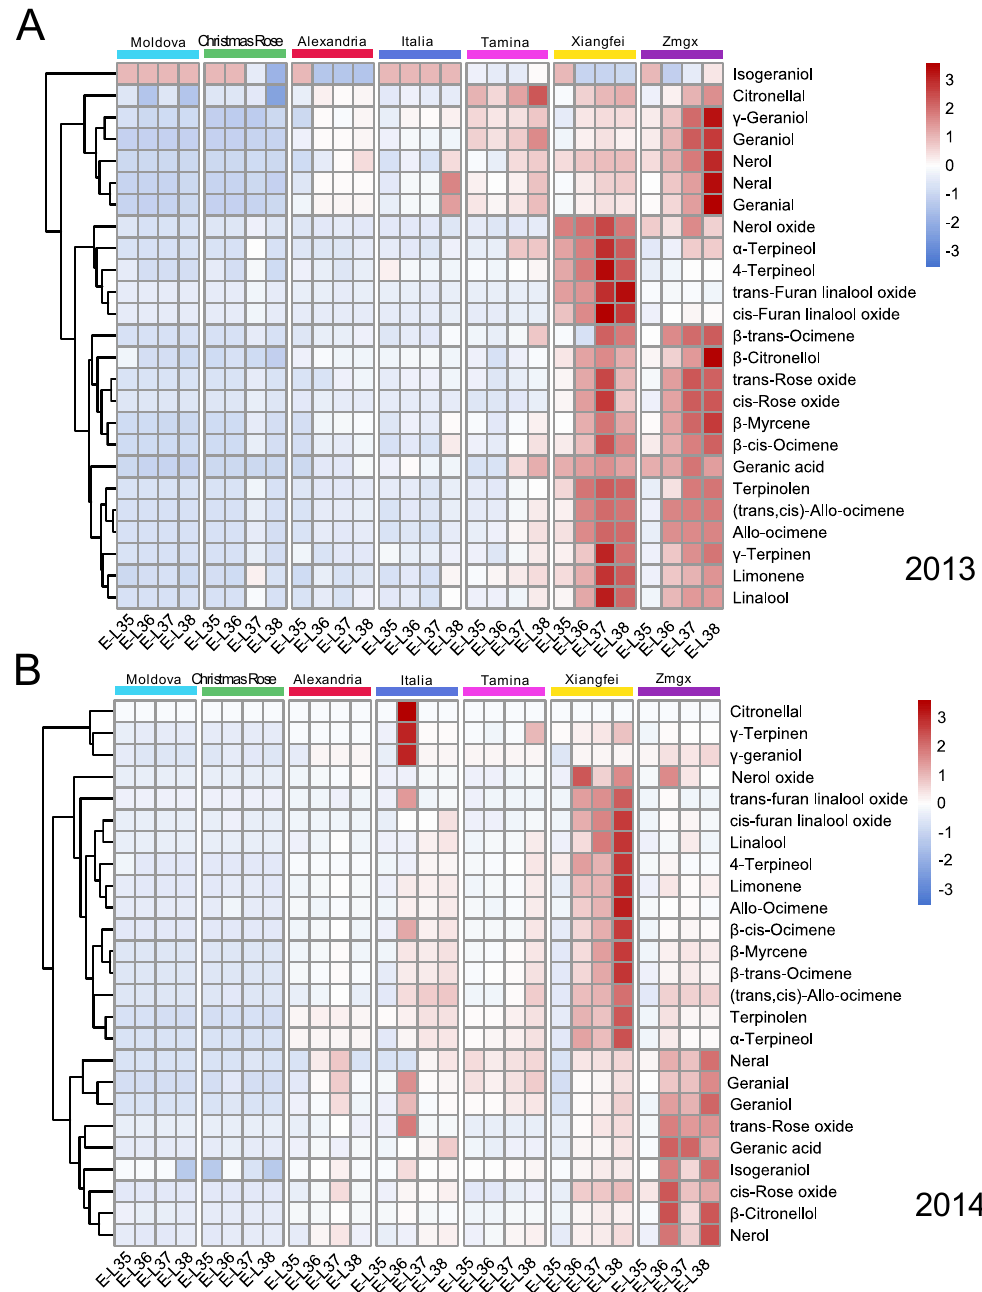
Figure 1. Heat plots of monoterpenoids of different table grape varieties during the development of berries in 2013 ( A ) and 2014 ( B ). ‘Alexandria’ represented ‘Muscat of Alexandria’, ‘Zmgx’ represented ‘Zaomeiguixiang’.